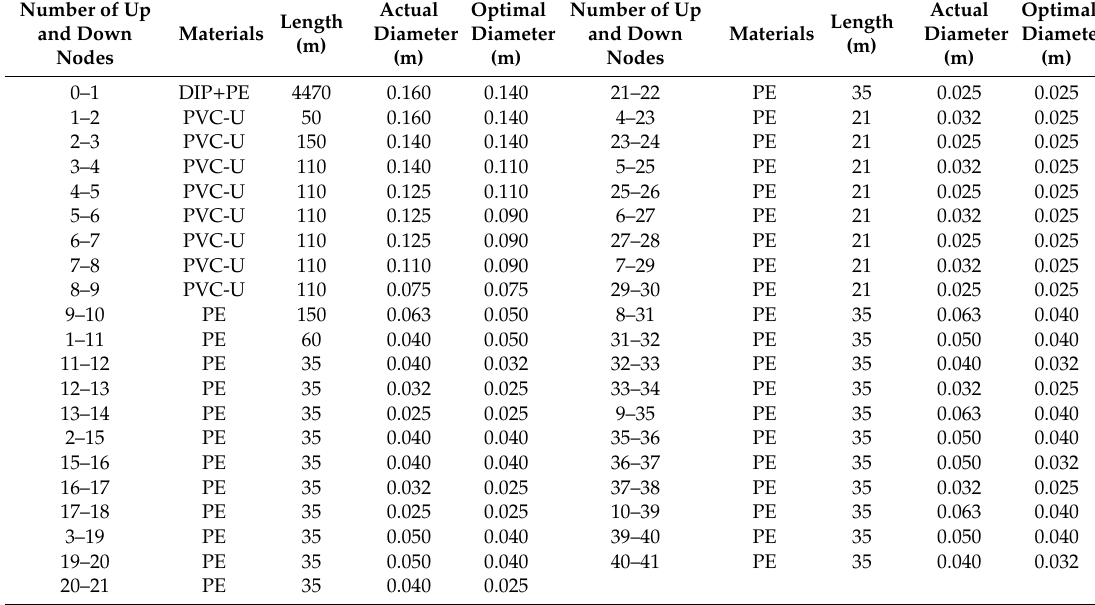
Table 2. Optimization results of diameters in each branch